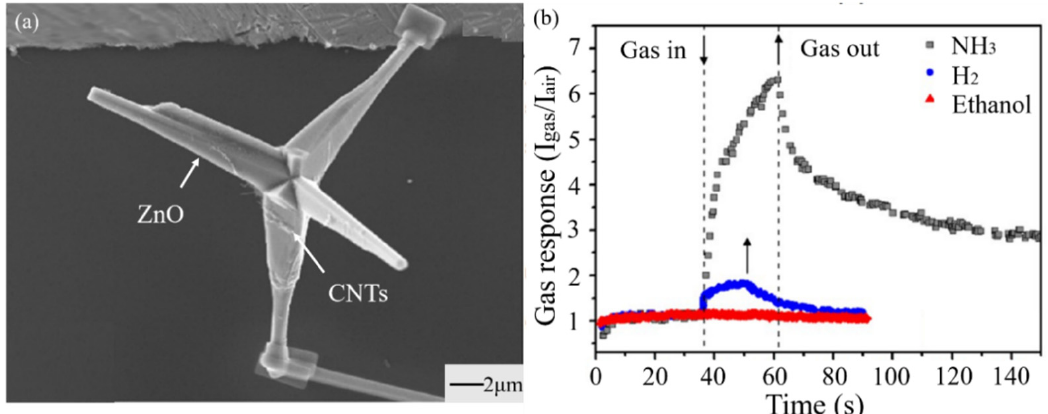
Figure 9. ZnO-T-CNT gas sensor. Adapted from [132] copyright (2017), with permission from American Chemical Society. ( a ) The morphology of CNTs and ZnO-T composite nanostructure; ( b ) the response of CNTs and ZnO-T composite nanostructure to NH 3 .